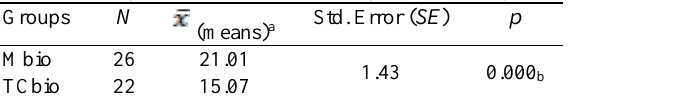
Table 3 LSD post-hoc test results for pairwise comparisons